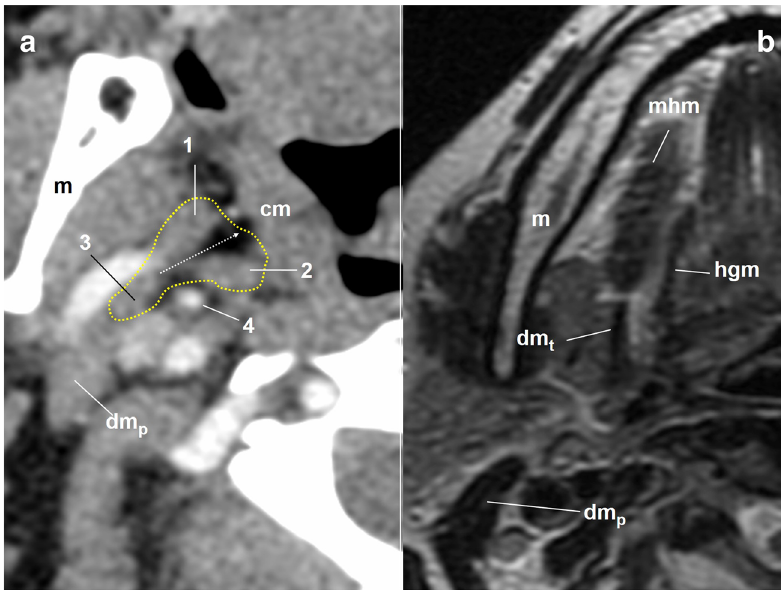
Fig. 10 Cervical portion of the glossopharyngeal nerve. a Axial contrast- enhanced CTscan of the neck, right side, soft tissues window. The dotted yellow line draws the limits of the styloid pyramid. 1: styloglossus muscle; 2: stylopharyngeus muscle; 3: stylohyoid muscle; 4: external carotid artery; cm: constrictor muscles. The dotted white arrow represents the long axis of the styloid pyramid as a reference of the gpn